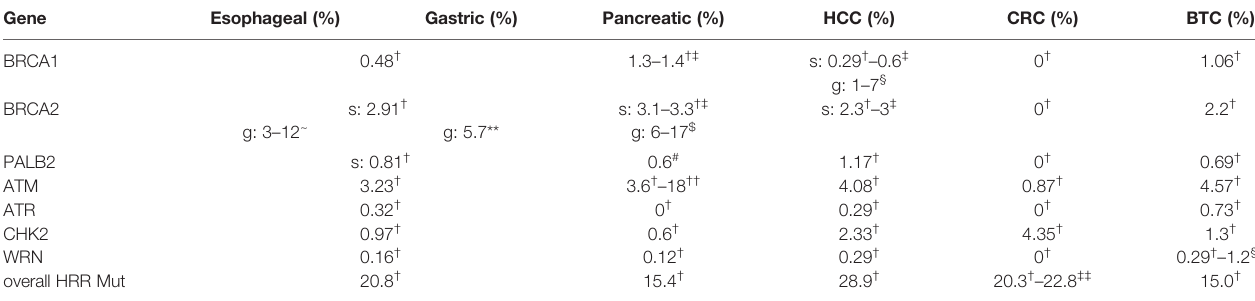
TABLE 1 | Mutation frequencies of BRCA1, BRCA2, and of other frequently mutated DDR